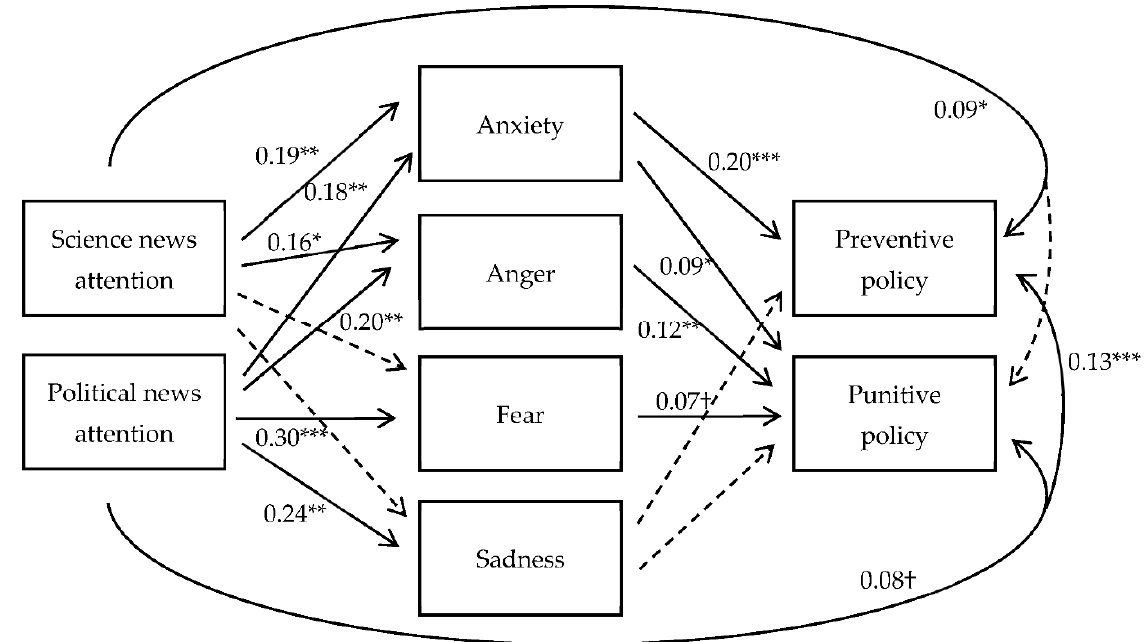
Figure 3. Results of hypothesized model. Note. Standardized coefficients are shown. The effects of control variables on emotions and policy support were estimated but not depicted here. † p < 0.10, * p < 0.05, ** p < 0.01, *** p < 0.001.